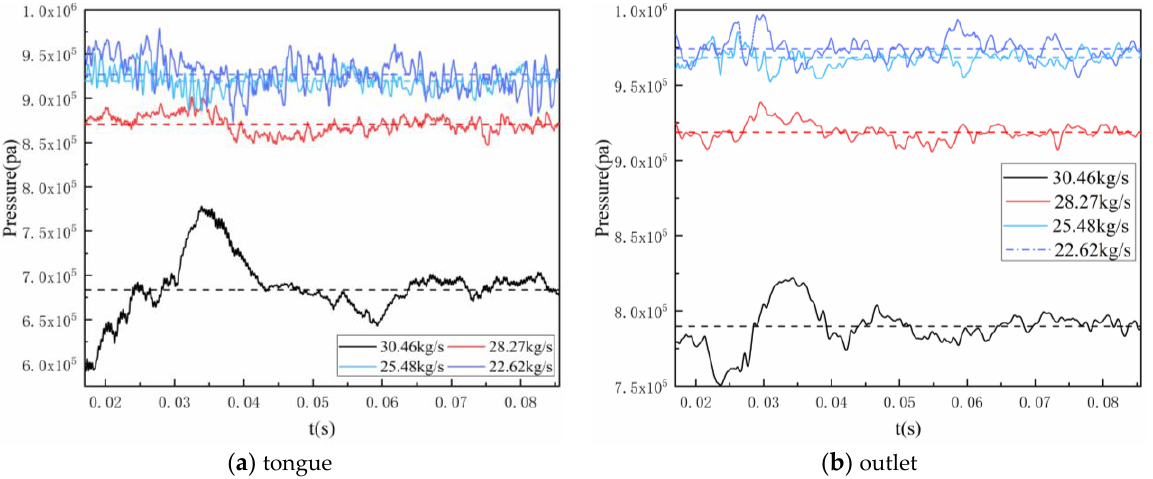
Figure 16. Pressure fluctuation at monitoring points of the tongue and outlet at four different mass-flow rates.